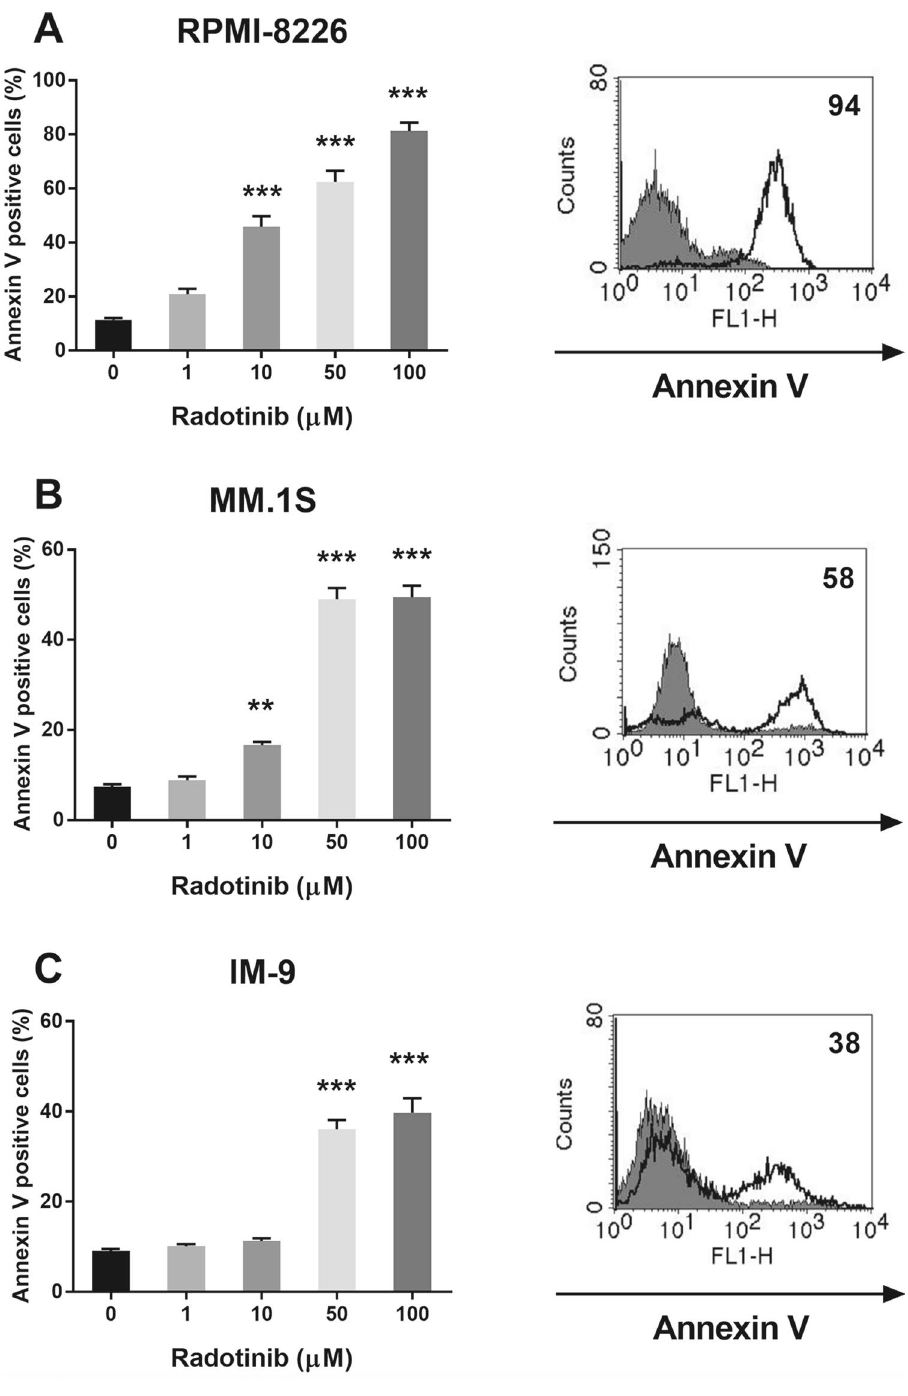
Figure 3. Radotinib induced apoptosis in MM cells. The cells were also collected and treated under the same conditions described above. Cells were stained with Annexin V, followed by flow cytometry analysis. Radotinib induced dose-dependent apoptosis in RPMI-8226 ( A ), MM.1S ( B ) and IM-9 cells ( C ). The filled histogram represents Annexin V positive cells treated with 0 µM radotinib (control group), and the open histogram represents Annexin V positive cells treated with 100 µM radotinib, respectively. Data are presented mean ± SEM.; ** P < 0.01.; *** P < 0.001. *Significantly different from control